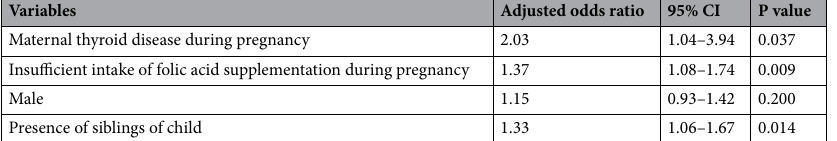
Table 4. Association between variables and onset of Kawasaki disease in infancy. KD Kawasaki disease, 95% CI 95% confidence